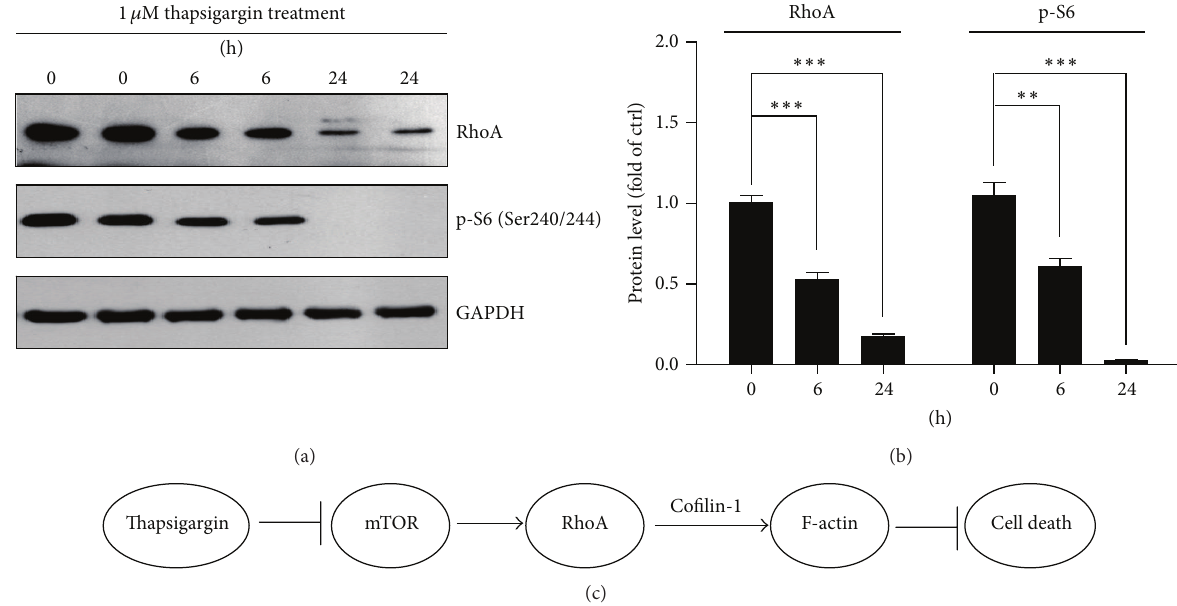
Figure 4: Thapsigargin impairs cytoskeletal dynamics via mTOR-RhoA pathways in A549 cells. The changes in the protein levels of RhoA and pS6 (S240/244) by thapsigargin treatment (1 𝜇 M for 6 and 24 h) in A549 cells were shown by Western blots (a) and histograms (b). Results are averages of four independent experiments. Data represent mean ± SEM. ∗∗ 𝑃 < 0.01 , ∗∗∗ 𝑃 < 0.001 . (c) Schematic representation highlighting the models of thapsigargin inducing cell apoptosis by impairing actin cytoskeletons in A549 cells. Thapsigargin may induce cell death in A549 cells, by disrupting the actin cytoskeleton organizations, which is mediated by inhibiting mTOR-RhoA-Cofilin-1